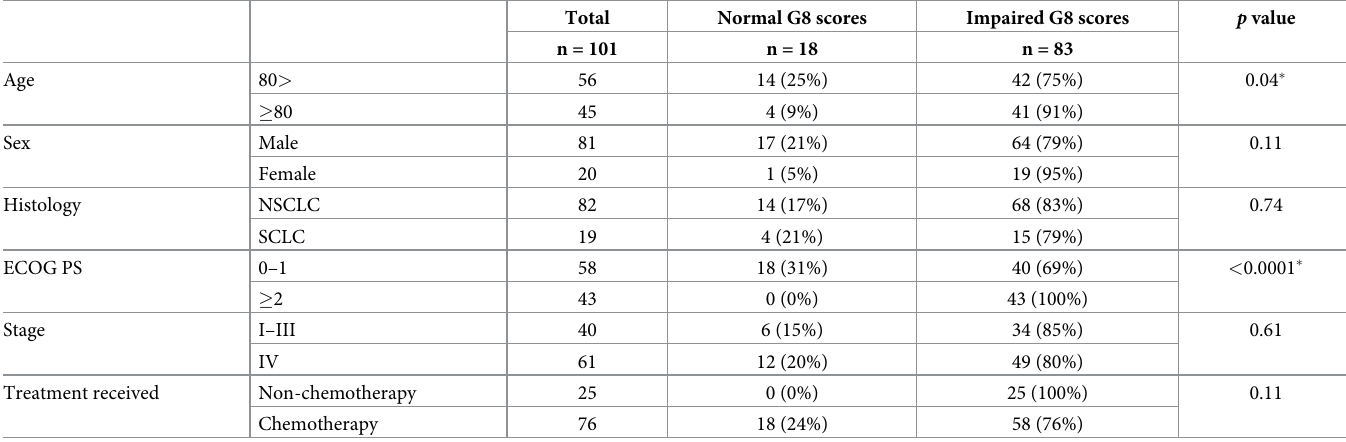
Table 2. G8 scores and patient characteristics (n = 101).